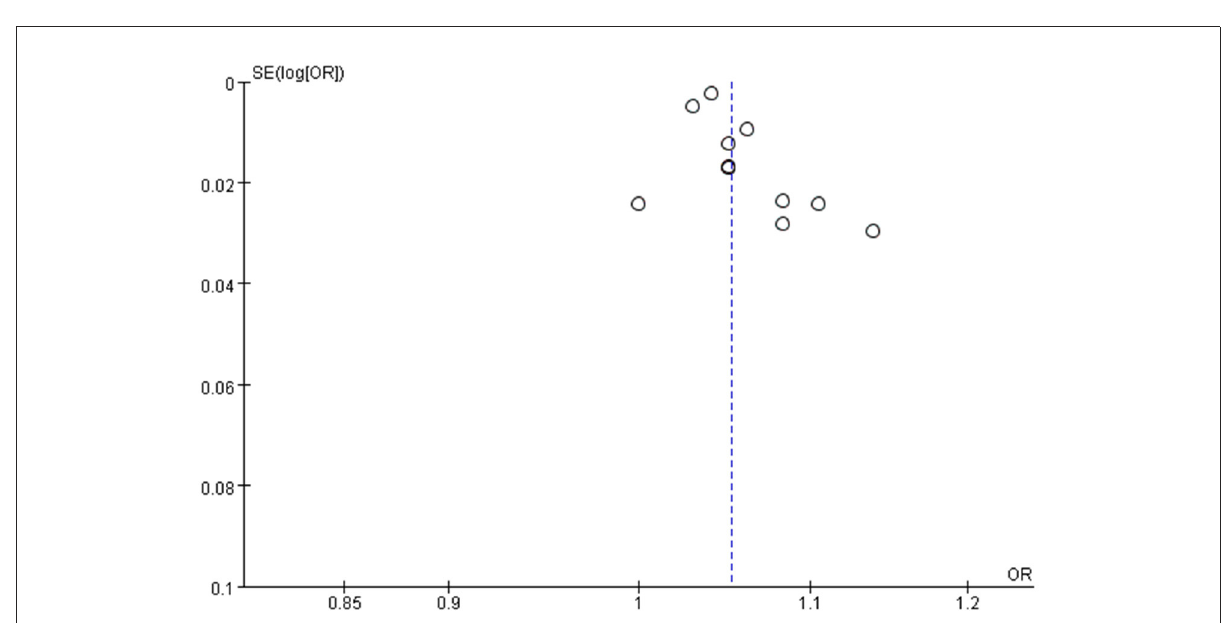
FIGURE2 Forest plot for age (per year increase).